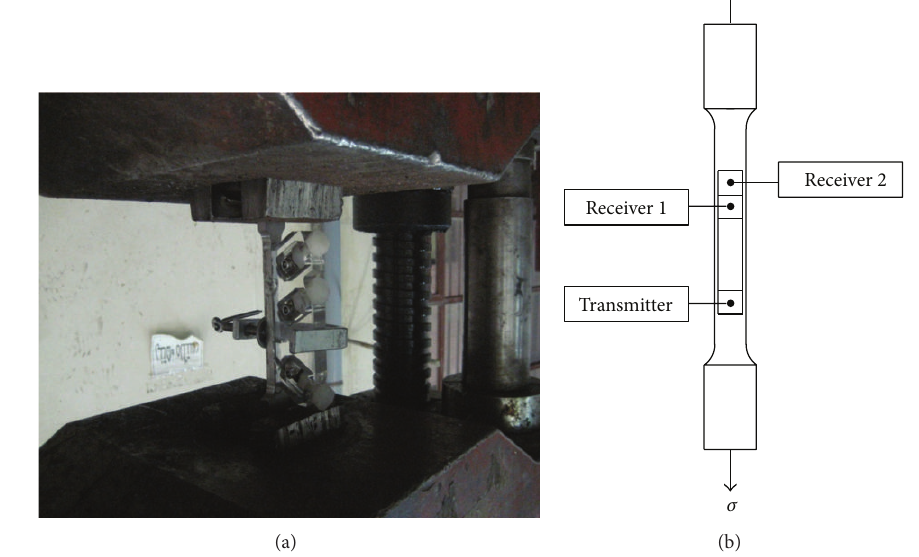
Figure 6: Tensile test to evaluate acoustoelastic constant ( 𝐿 11 ).